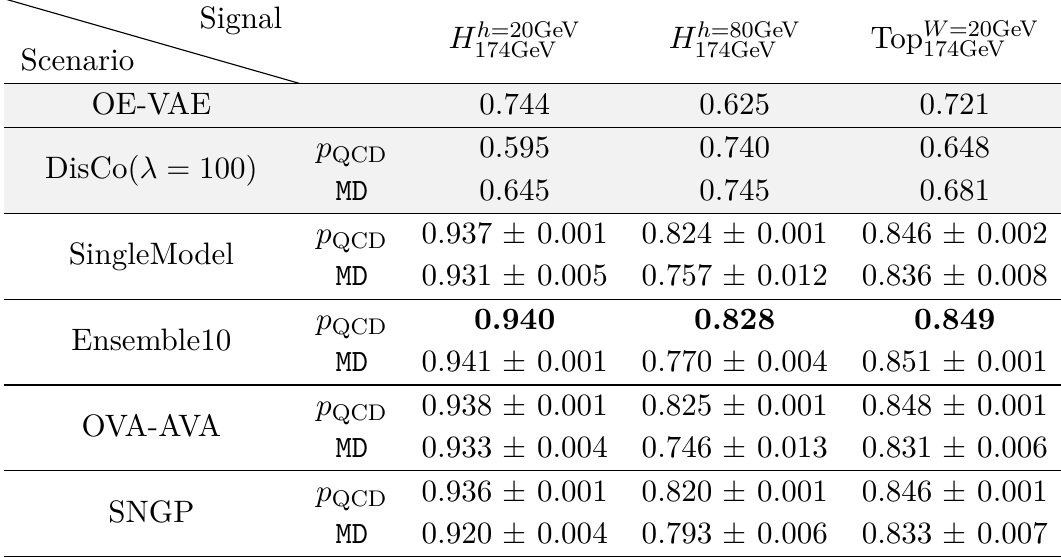
Table 3 . OoD test AUCs under mass decorrelation for different model training strategies and anomaly scoring functions ( p QCD and Mahalanobis distance MD ). Standard deviations are calculated from 10 random runs, except that for the Ensemble model we bootstrap for 5 times from 20 individual models. (In the case of a too-small ( < 0 . 001 ) standard deviation, we omit it in the table.) For each test signal, the highest AUC is highlighted in bold. 8 Results from the mass-decorrelated Variational Autoencoders are shown as a reference. In addition, we also present a regularization-based mass decorrelation method (DisCo) as a